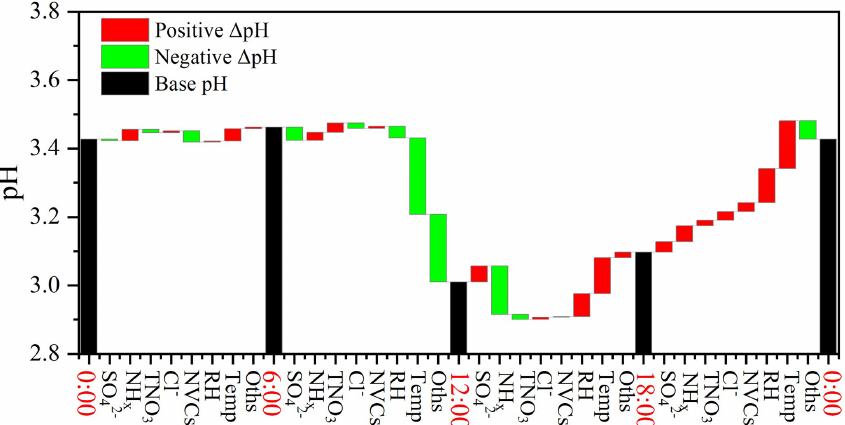
Figure 5. Contributions of individual factors to the (cid:49) pH between day and night. Here the black bars indicate the mean pH of different hours, and the red and green bars represent the positive and negative effects of individual factors on (cid:49) pH between two adjacent scenarios, e.g., 00:00 and 06:00LT, respectively. The meanings of the abbreviations: RH, relative humidity; Temp, temperature; NVCs, non-volatile cations; NH x , total ammonia; TNO 3 , total nitrate; Oths,